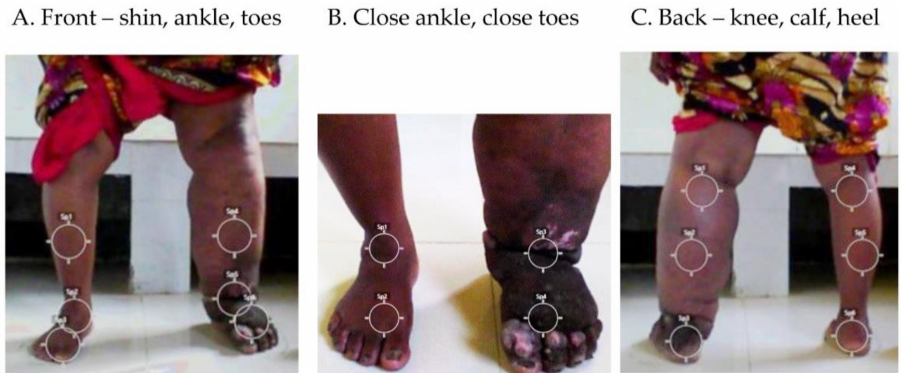
Figure 1. Location of temperature regions of interest (ROI) on front and back of legs. In total eight ROI on each leg were selected and included ( A ) the anterior leg at shin, ankle and toes on the whole-leg at 1m distance; ( B ) close-up of ankle and toes at 0.5 m distance; ( C ) the posterior leg at the back of the knee, calf and heel on the whole-leg at 1m